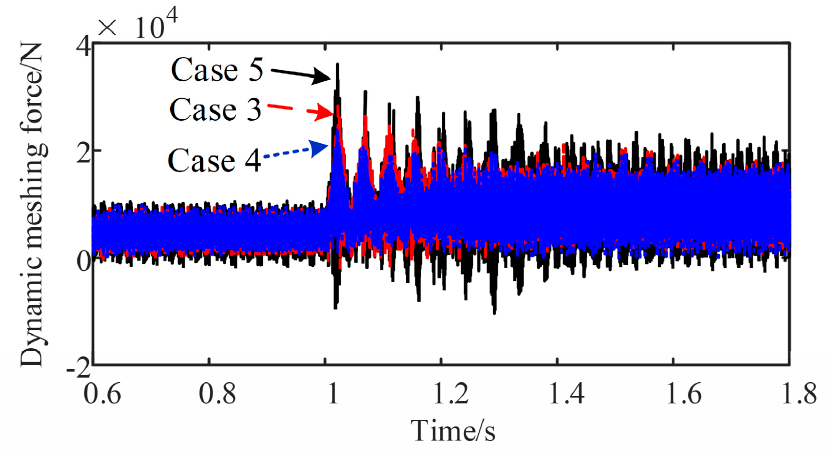
Table 7. Motor shaft damping and stiffness.